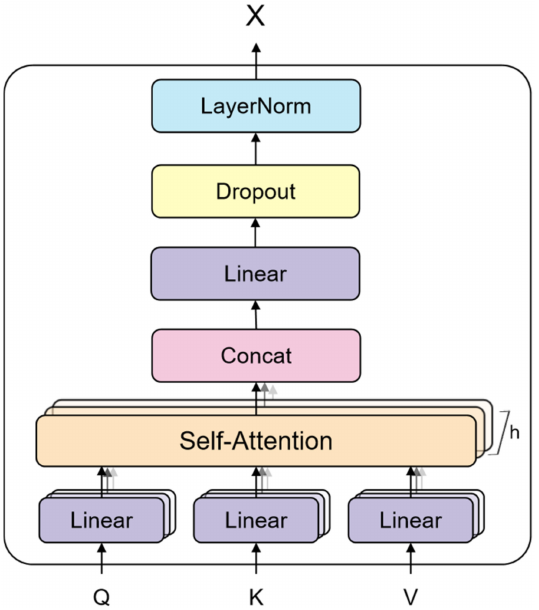
Figure 9. Multi-head attention network consisting of multiple self-attention layers—Concatenate layer, Linear layer, Dropout layer, and LayerNorm